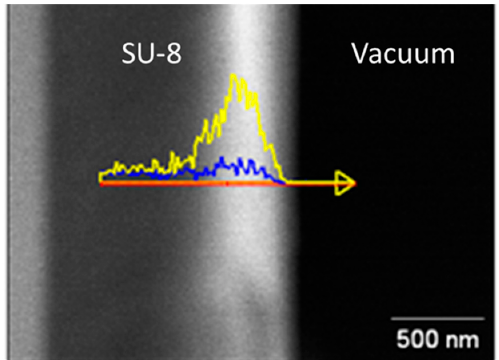
Figure 1. Energy-dispersive X-ray spectroscopy (EDS) data of the L-shell for Zn (yellow) from infiltrated ZnO and the K-shell for Al (blue) from the Al 2 O 3 seed layer in SU-8 (cross sectional view).